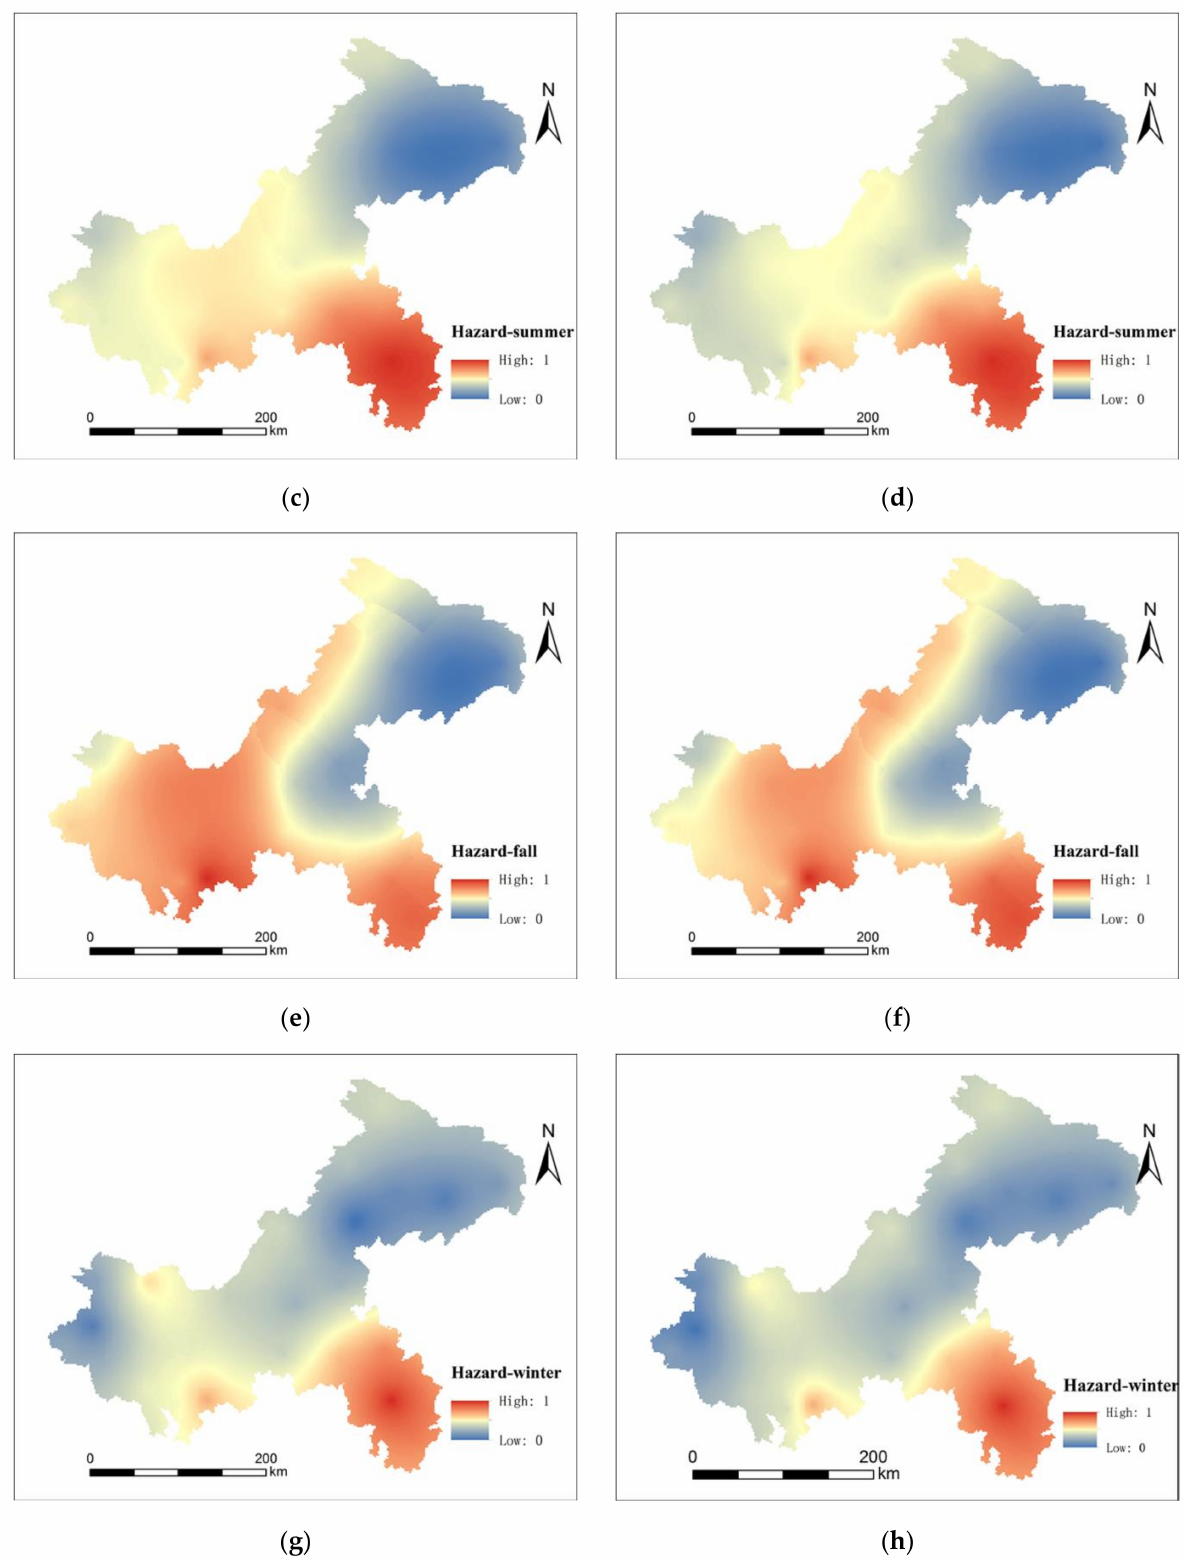
Figure 5. Spatial distribution map of flood hazard in four seasons during 2018: ( a ) Spring—AHP, ( b ) Spring—TFN-AHP, ( c ) Summer—AHP, ( d ) Summer—TFN-AHP, ( e ) Fall—AHP, ( f ) Fall—TFN-AHP, ( g ) Winter—AHP, ( h )